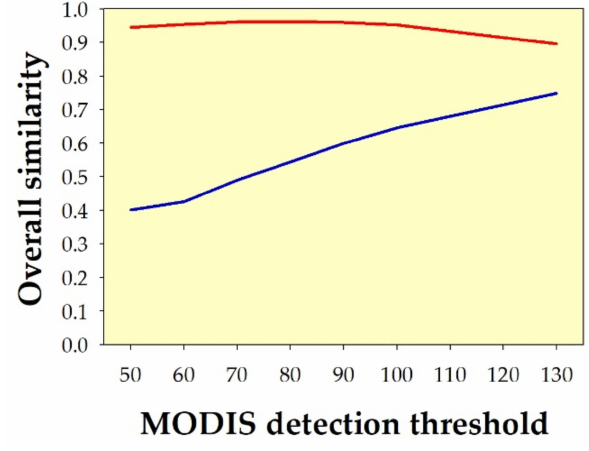
Figure 26. Overall similarity (i.e., the average of θ and δ similarities) of spatial pattern (red line) and temporal pattern (blue line) between deforestation hotspots in Indonesia in 2020 derived from Landsat-8 OLI (using the classification method described in Appendix A, at clarity ≥ 50% and deforestation intensity ≥ 50%) and deforestation hotspots in Indonesia in 2020 derived from MODIS (using the change-detection algorithm developed by [30], at change-detection thresholds ranging from 50 to 130). In this case, the overall similarity was calculated using the new Ruzicka–Fidelity metric (see Equation (1)), and time-series data were interpolated at a time slice of 1